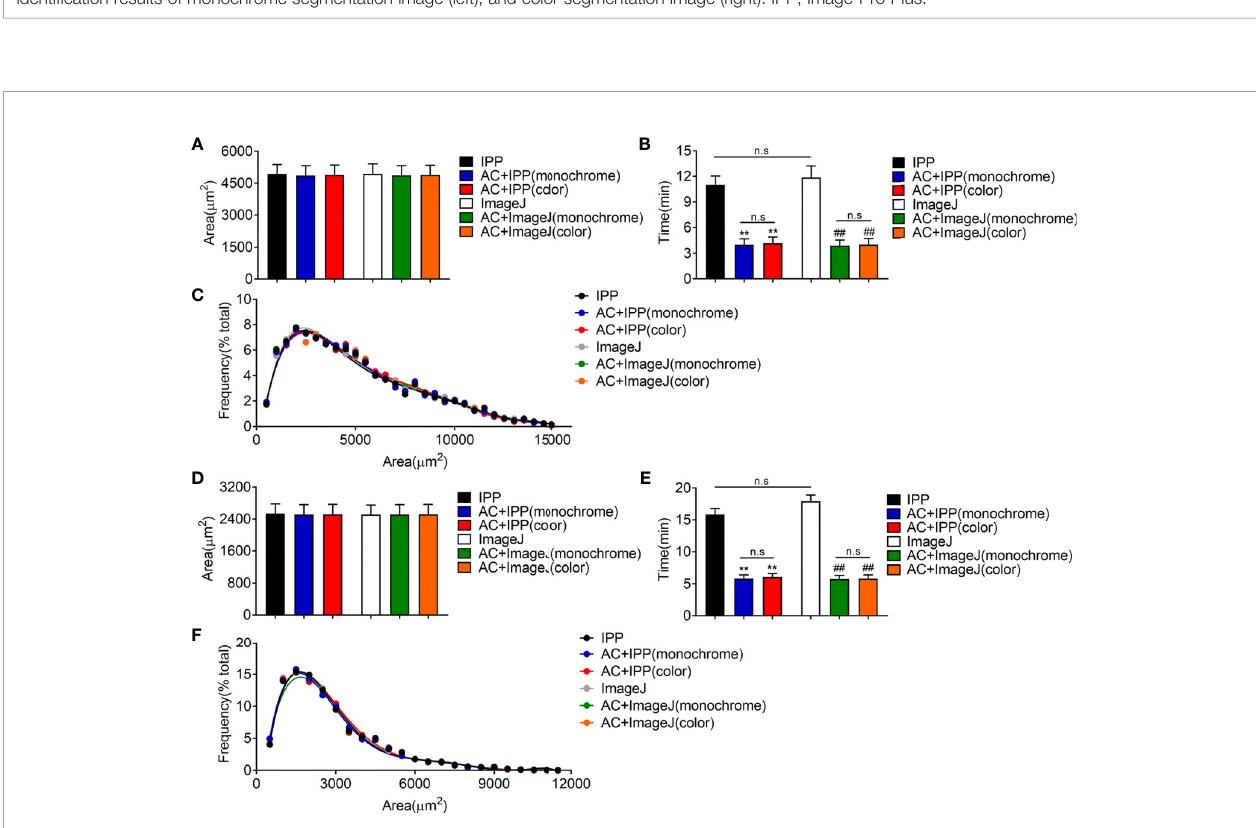
FIGURE 4 | The combined methods can measure the area accurately and take less time in eWAT and iWAT of obese mice. (A – C) The measurement results of eWAT, adipocyte sizes derived from manual and combined methods (A) , measurement time (B) , adipocyte size distributions measured by manual and combined methods (C) . (D – F) The measurement results of iWAT. Data are presented as mean ± SEM and **P < 0.01 compared to IPP manual measurement group. ## P < 0.01 compared to ImageJ manual measurement group. n.s., not signi fi cant; IPP, Image-Pro Plus; AC, AdipoCount.